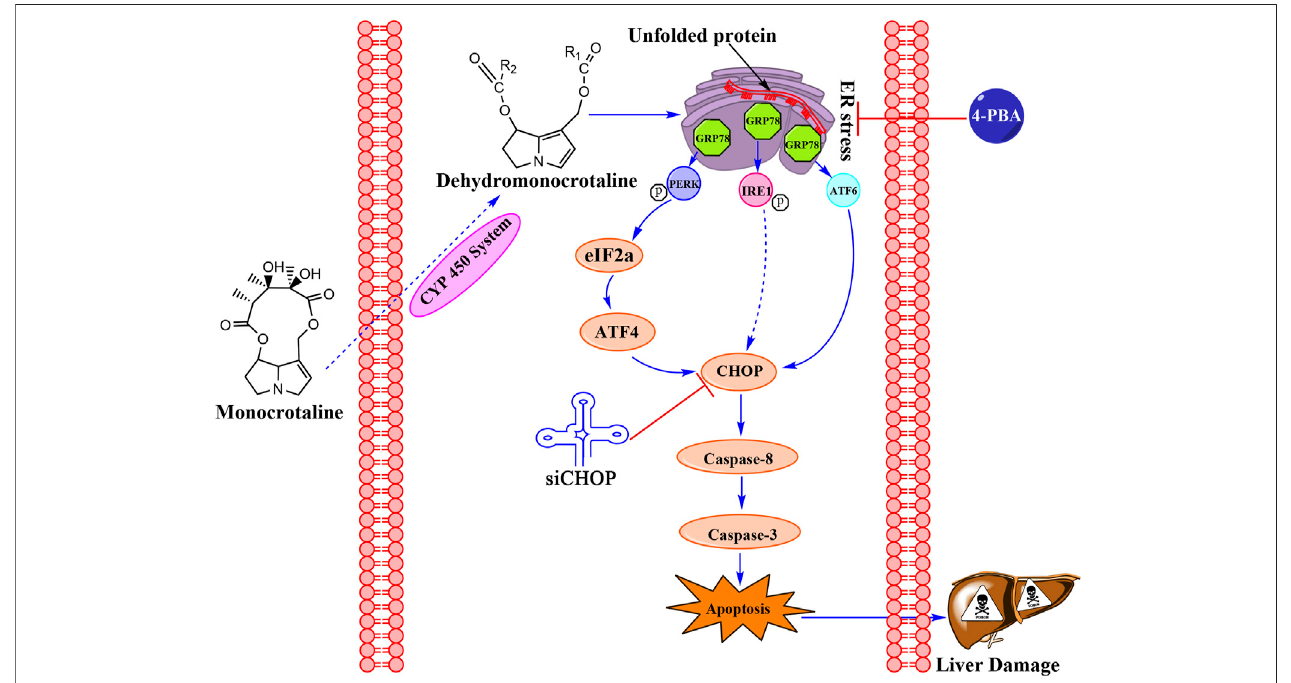
FIGURE 6 | The signaling pathway involved in MCT-induced apoptosis in primary rat hepatocytes.